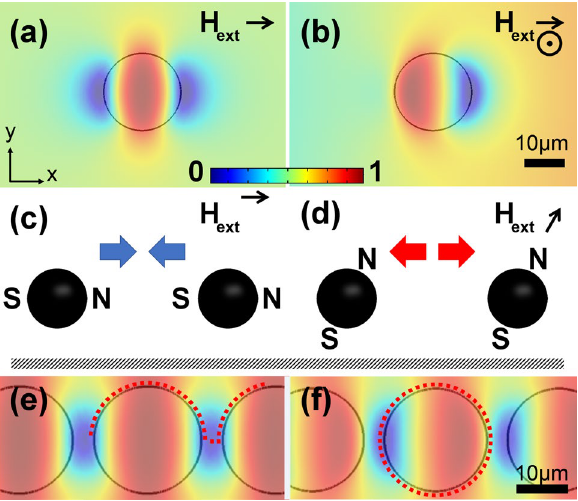
Figure 1. The effect of vertical bias field in magnetophoretic circuits. The magnetic energy landscape simulation results above the substrate for a magnetic disk, ( a ) exposed to an in-plane magnetic field, and ( b ) after superimposing a vertical bias field are shown. The blue and red areas stand for the regions with low and high magnetic energies, respectively. Here, we did a min–max normalization to scale the magnetic energy between 0 and 1 (see the legend). The black arrow and the dot depict the external magnetic field direction and the vertical magnetic fields, respectively. Side view schematics of the magnetic particle alignment in an ( c ) in-plane magnetic field and ( d ) after superimposing a vertical bias field are illustrated. The black circles and the shaded area depict the magnetic particles and the substrate, respectively. The blue and red arrows stand for the attractive and repulsive forces, respectively. N and S depict the north and south poles, respectively. The magnetic energy landscape simulation results above the substrate for a disk-based magnetophoretic circuit ( e ) exposed to an in-plane magnetic field and ( f ) after superimposing a vertical bias field are illustrated. The dotted lines stand for the particle trajectories.